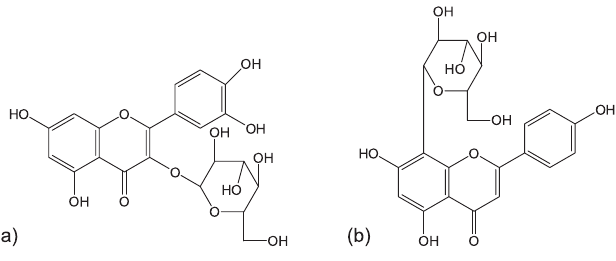
FIGURE 1 - Chemical structures of isoquercitrin (a) and vitexin